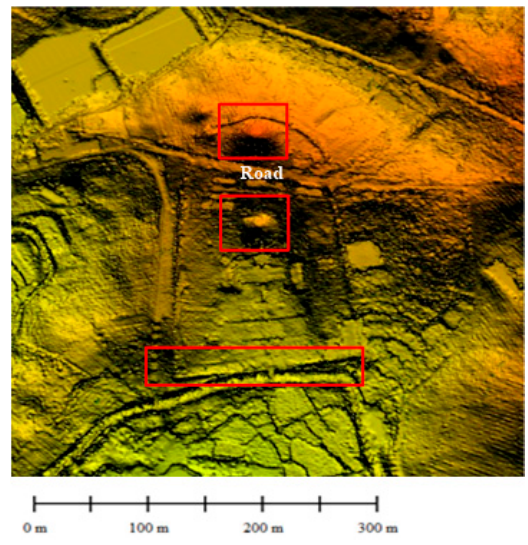
Figure 3. Tomb divided by a road network and residential blocks.